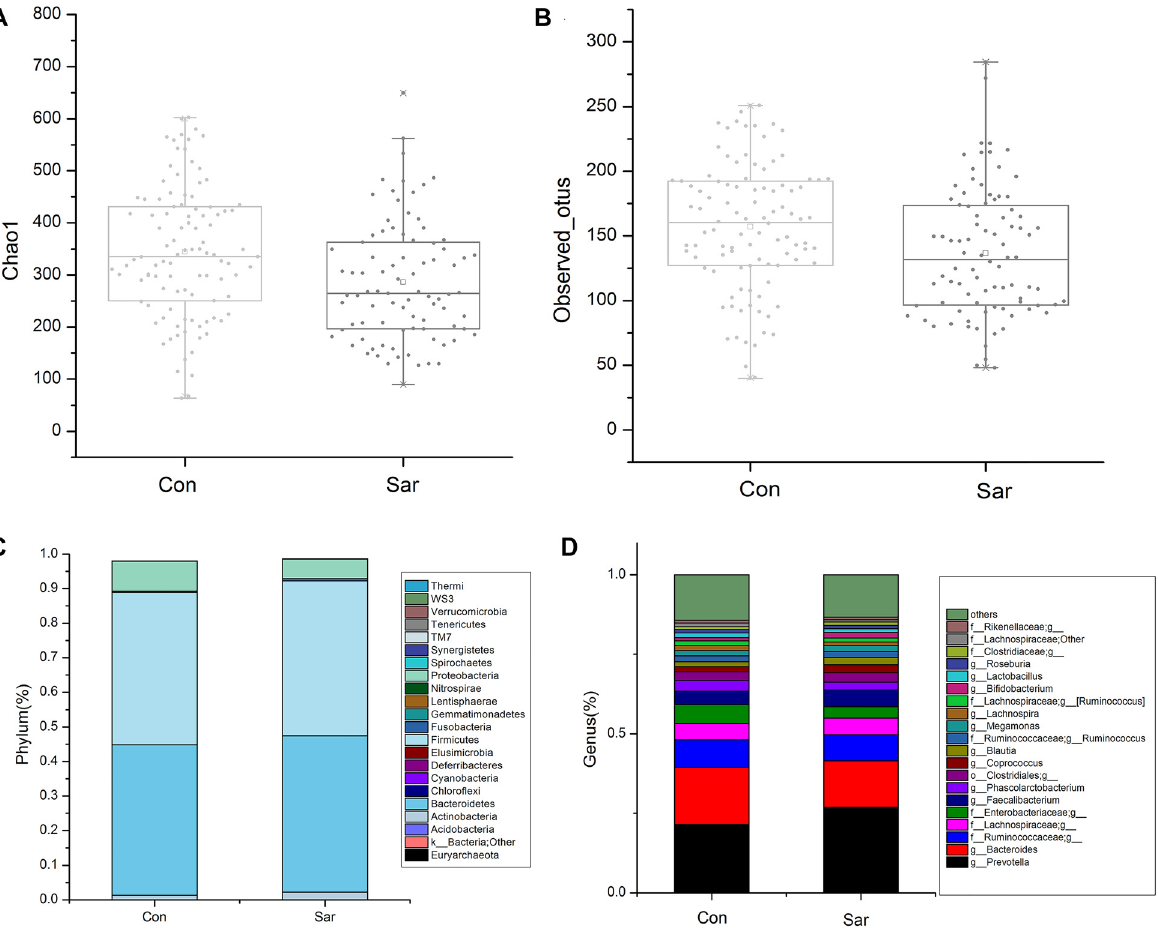
Figure 1: Box plot graph of alpha diversity based on the Chao1 value (A) and observed OTUs (B). Relative abundance map of intestinal phyla (C) and genera (D) in the control group and sarcopenia